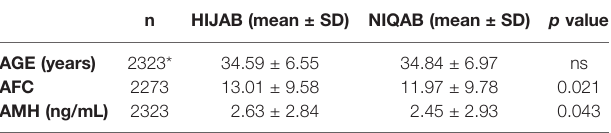
*Patients with dress code and AMH data included for the analysis, out of the total population (n=2495). n, number of patients included; SD, standard deviation; ns, non signi fi